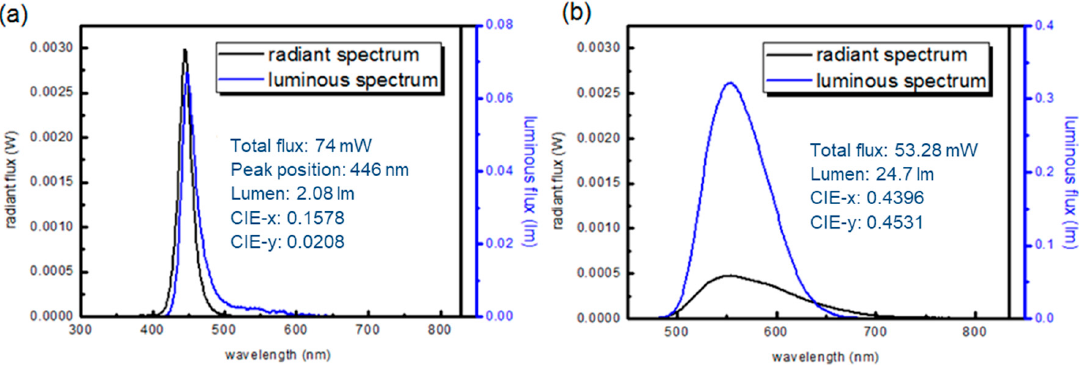
Figure 3. Spectra of leaked blue rays: ( a ) I = 1 (only blue light) and ( b ) I = 0 (no blue light).